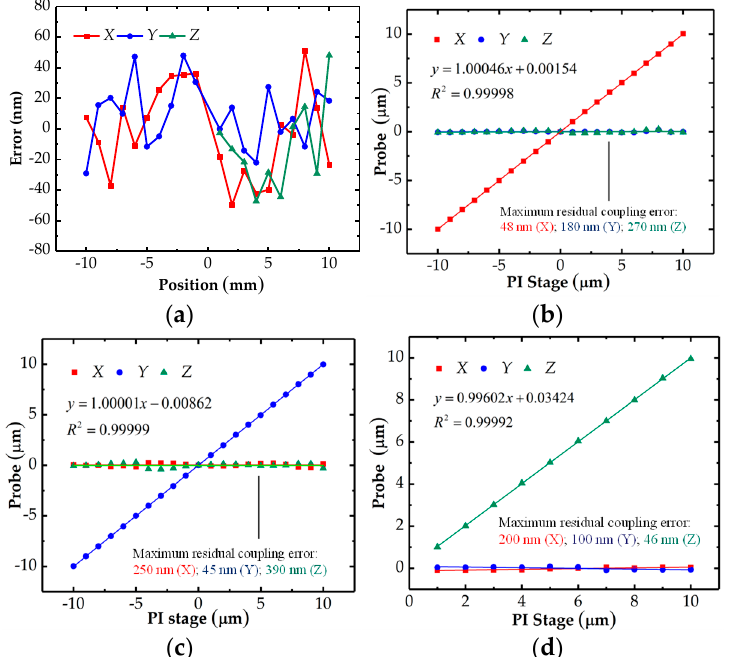
Figure 15. Results of the decoupling process: ( a ) residual errors; ( b ) in X direction; ( c ) in Y direction; ( d ) in Z direction.